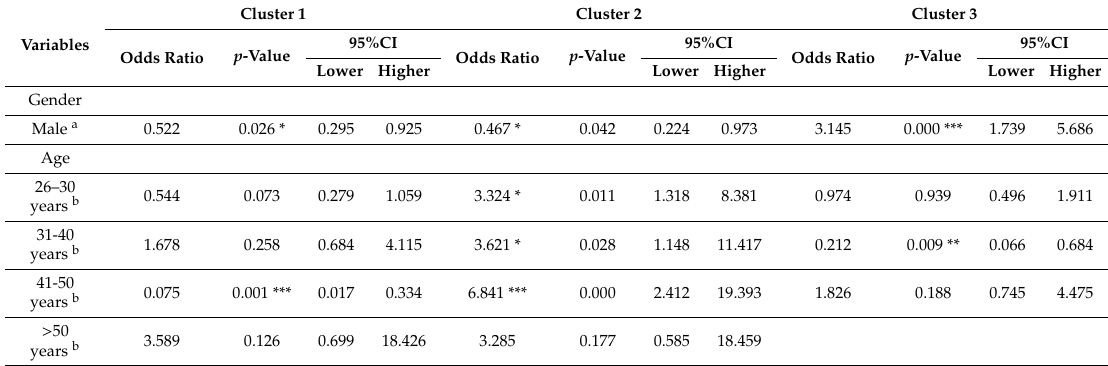
Table 8. Binary logistic